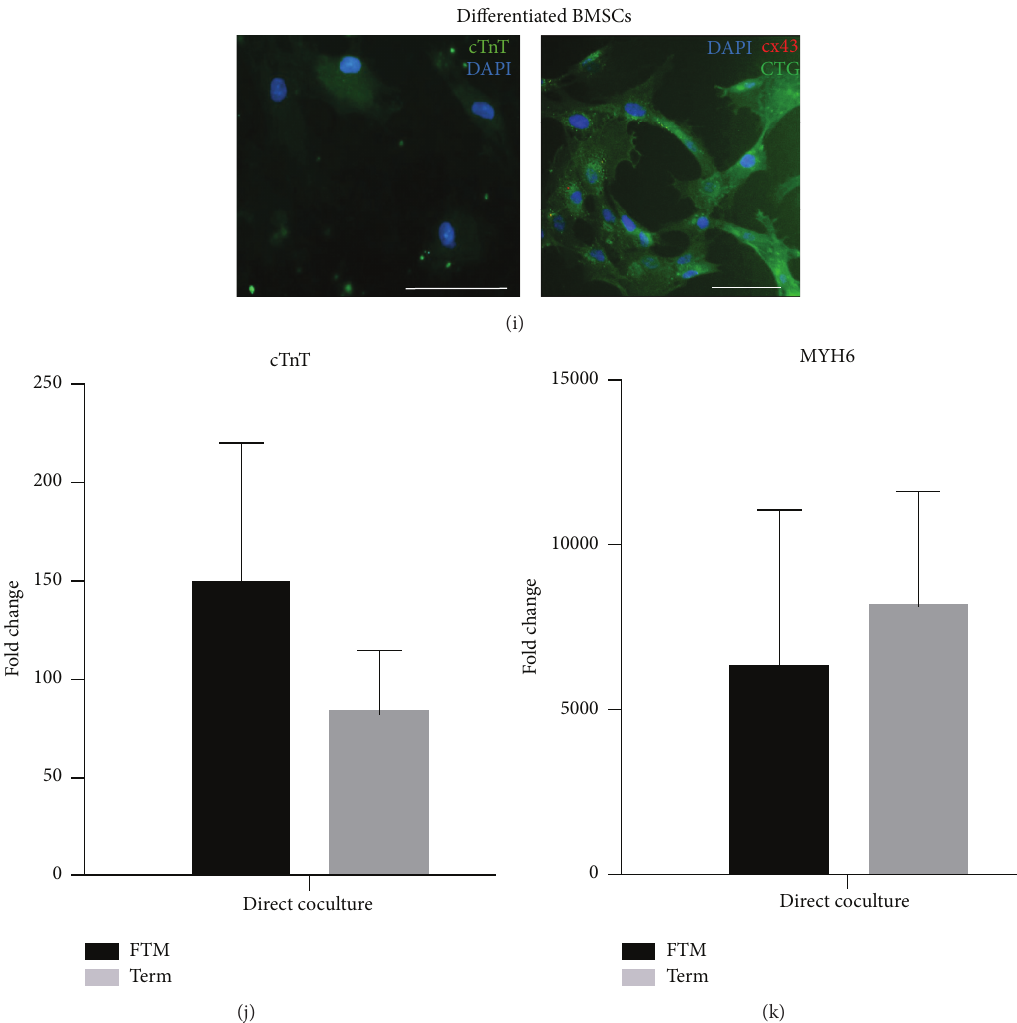
Figure 2: In vitro cardiomyogenic differentiation of human MSCs. (a–d) FC analysis of hMSCs. Undifferentiated MSC markers SSEA4 (a) and CD146 (b), cardiomyocyte marker SIRPA (c), and gap junction protein connexin 43 (cx43, (d)) levels expressed as % of overall human cell counts in undifferentiated and differentiated (direct coculture, aggregate coculture) first trimester PVC (FTM), term HUCPVC (term), and bone marrow (BMSC). ∗ indicates statistically significant difference ( 𝑝 < 0.01 , 𝑛 FTM = 9 , 𝑛 term = 9 , 𝑛 BMSC = 6 ). (e) Confocal microscopy images of Mef2c (green) and HuNu (red) immunostaining in FTM and term HUCPVCs and bone marrow MSC containing rat primary cardiomyocyte cultures in comparison with undifferentiated MSCs. Blue: Hoechst (DAPI) Arrows mark double positive nuclei. Bar = 100 𝜇 m. (f) Quantification of Mef2c and HuNu double positive nuclei in direct cocultures, expressed as % of HuNu positive (overall hMSC) counts. 50 independent, random fields of sight assessed per MSC type. ∗ 𝑝 < 0.01 . (g–i) Confocal microscopy images of TRA-1-85 high FTM and term HUCPVCs sorted from direct cocultures compared with undifferentiated cultures. Connexin 43 ((h, i), red) and cardiac troponin T ((g, i), green) stainings. For connexin 43, cells were counterstained with fixable dye (CellTracker Green). (h) Inner box: 2x magnification of representative fields showing intracellular distribution of cx43 positive puncta. Scale bars (e, i): 100 𝜇 m; (g, h): 𝑥 = 54 𝜇 m and 𝑦 = 48 𝜇 m and 𝑥 = 100 𝜇 m and 𝑦 = 110 𝜇 m. Blue: Hoechst (DAPI filter). (j, k) Quantitative PCR analysis of cardiac troponin T (cTnT, (j)) and heavy chain cardiac myosin (MYH6, (k)) in TRA-1-85 high FTM and term HUCPVCs sorted from direct cocultures. Values expressed as fold change in comparison to undifferentiated cells. 𝑛 = 4